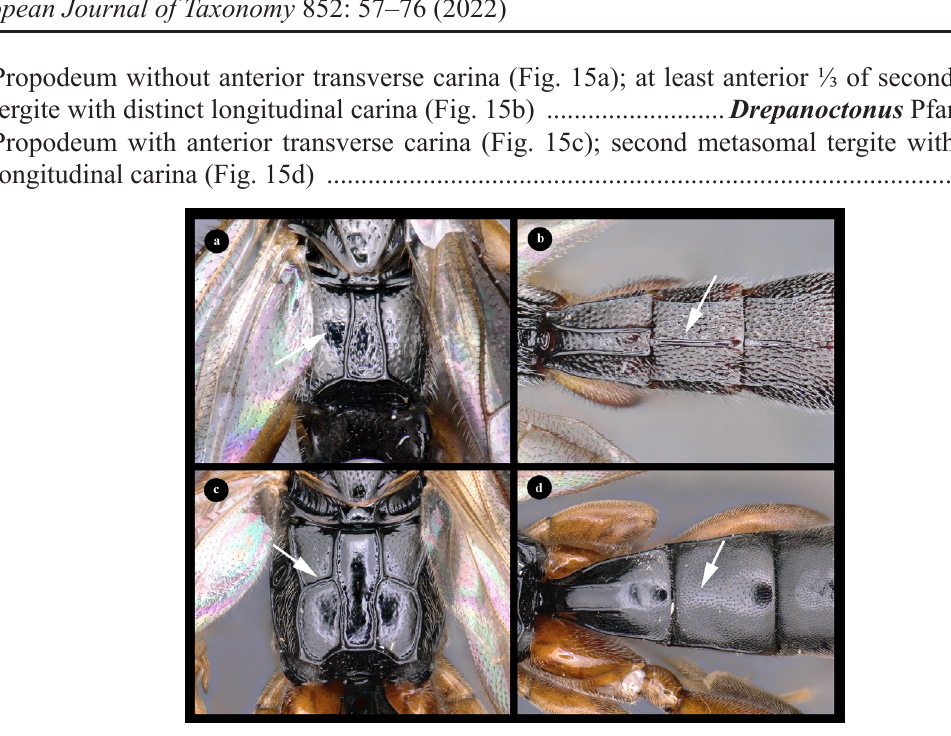
Fig. 15. a. Carria sp., propodeum, dorsal view. b . Trieces isolatus Ranjith & Priyadarsanan, 2022, anterior metasomal tergites, dorsal view. c–d . Hypsicera sp. c . Propodeum, dorsal view. d . Anterior metasomal tergites, dorsal view. Arrow in Fig. 15a points to the absence of anterior transverse carina of propodeum (compared to the presence of anterior transverse carina of propodeum in Fig. 15c). Arrow in Fig. 15b points to the presence of midlongitudinal carina on second metasomal tergite (compared to the absence of midlongitudinal carina on second metasomal tergite in Fig. 15d).